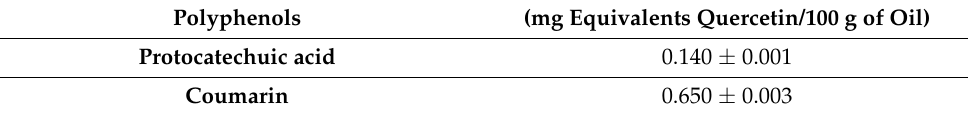
Table 2. Pistacia lentiscus seed oil polyphenol content (mg equivalents quercetin/100 g of